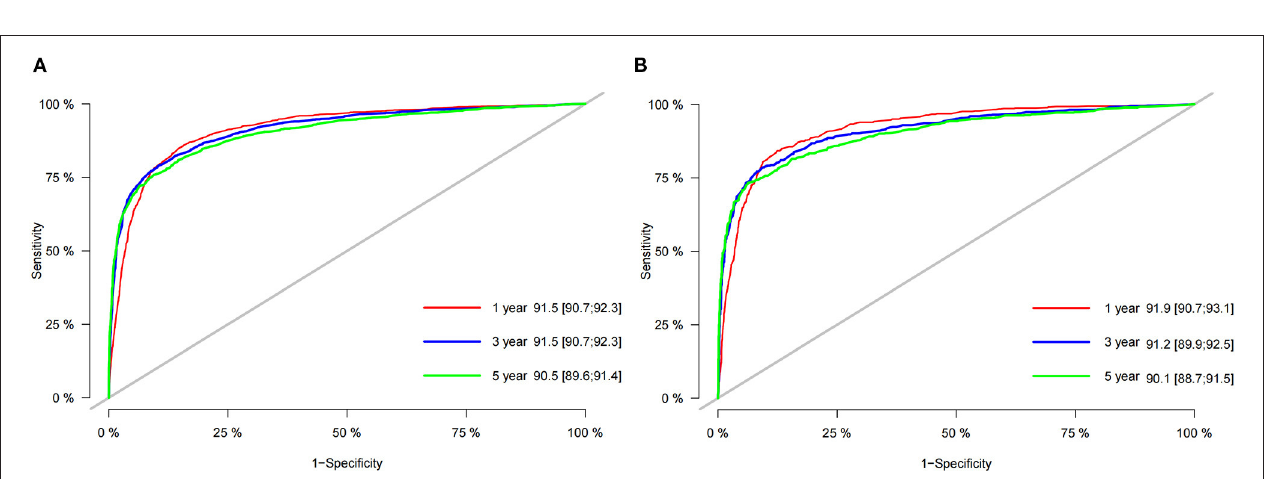
FIGURE 4 | AUC for predicting 1-, 3-, and 5-year CSS in the training cohort (A) and the validation cohort (B) .